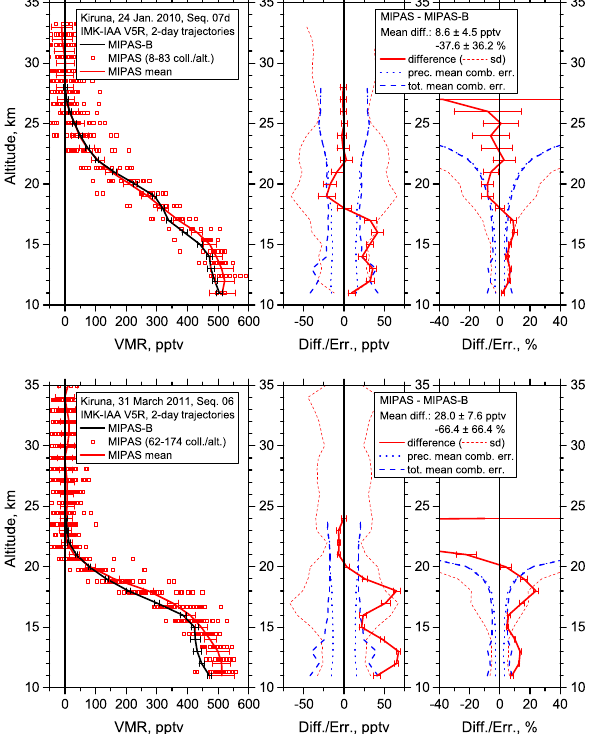
Figure 18. Comparison of a mean profile of MIPAS CFC-12 collocated measurements (left panels: red line) with a profile of MIPAS-B (black line) obtained on 24 January 2010 (upper panels) and 31 March 2011 (lower panels) at Kiruna. The error bars (1 σ ; left panel) show the total error without the spectroscopy error for MIPAS and MIPAS-B. The difference is shown in absolute (middle panels) and relative (right panels) terms. The dotted red line is the standard deviation and the dashed blue line is the combined error which consists of the root of the squared error of MIPAS-B and the MIPAS mean.